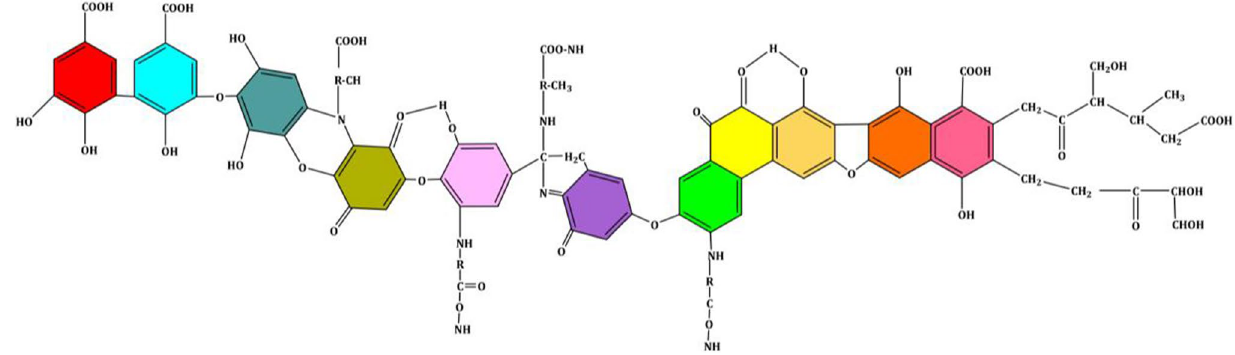
Fig. 1 Humic acid structure from the literature (Mirza et al. 2011; de Melo et al. 2016; Raj et al. 2022)